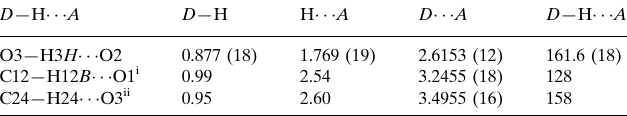
Hydrogen-bond geometry (A˚ , (cid:1)